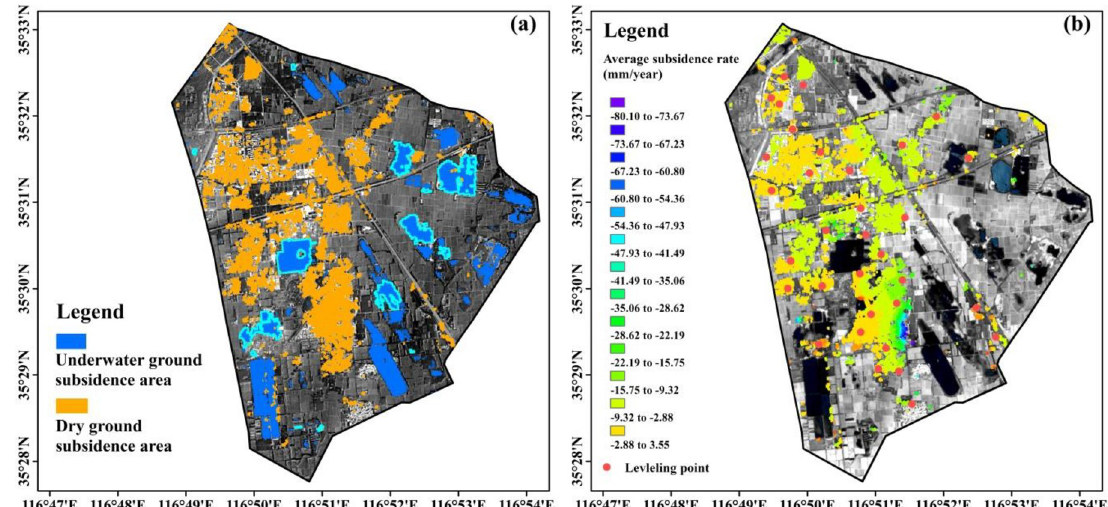
Fig 4. Subsidence area identification using the optical and microwave remote sensing images. (a): Underwater and dry ground subsidence areas, the 15 highlighted waterbodies were used for verifying the subsidence rate estimates. (b): Estimated average subsidence rates in the study area; red dots denote the locations of leveling points. The analysis results were overlaid on the Landsat-8 OLI image of June 2017, which was obtained from the public domain: http://eros.usgs.gov of the Earth Resources Observatory and Science (EROS)